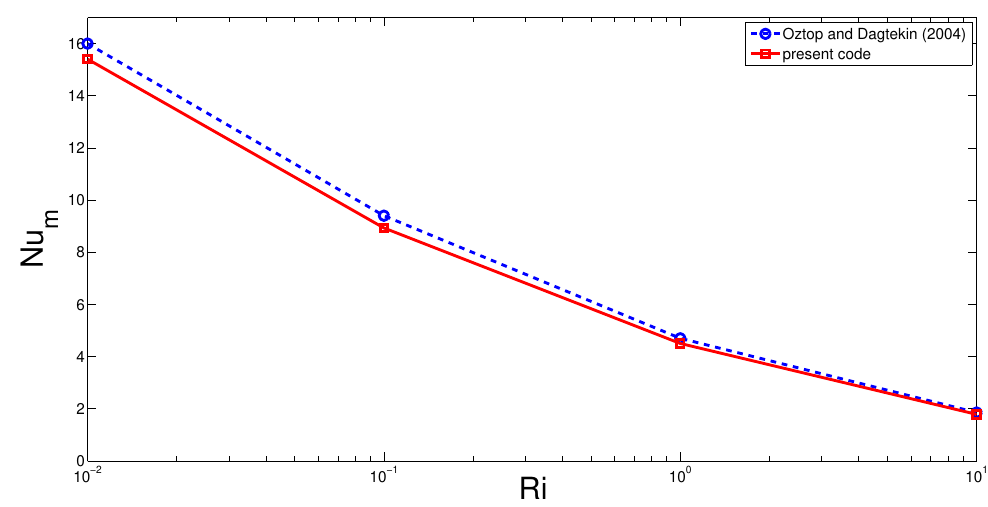
Figure 3. Average Nusselt number comparisons for various Richardson numbers for a double lid driven cavity problem (opposite lid velocity direction) computed in ref. [60] and obtained with the current